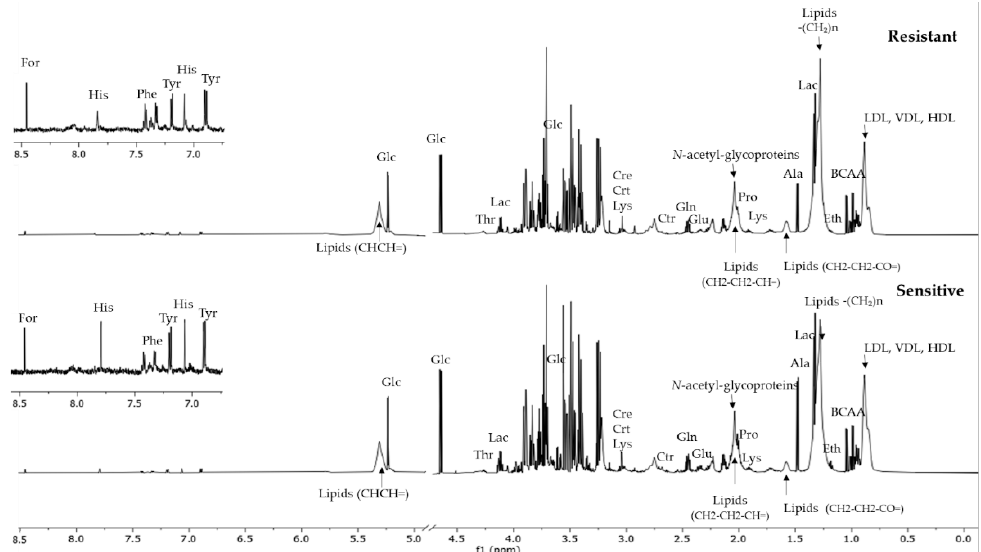
Cancers 2022 , 14 , x FOR PEER REVIEW Figure 1. Representative 1H-NMR spectra from serum obtained from women before they initiated the NACT. Resistant and sensitive refer to response to neoadjuvant chemotherapy.